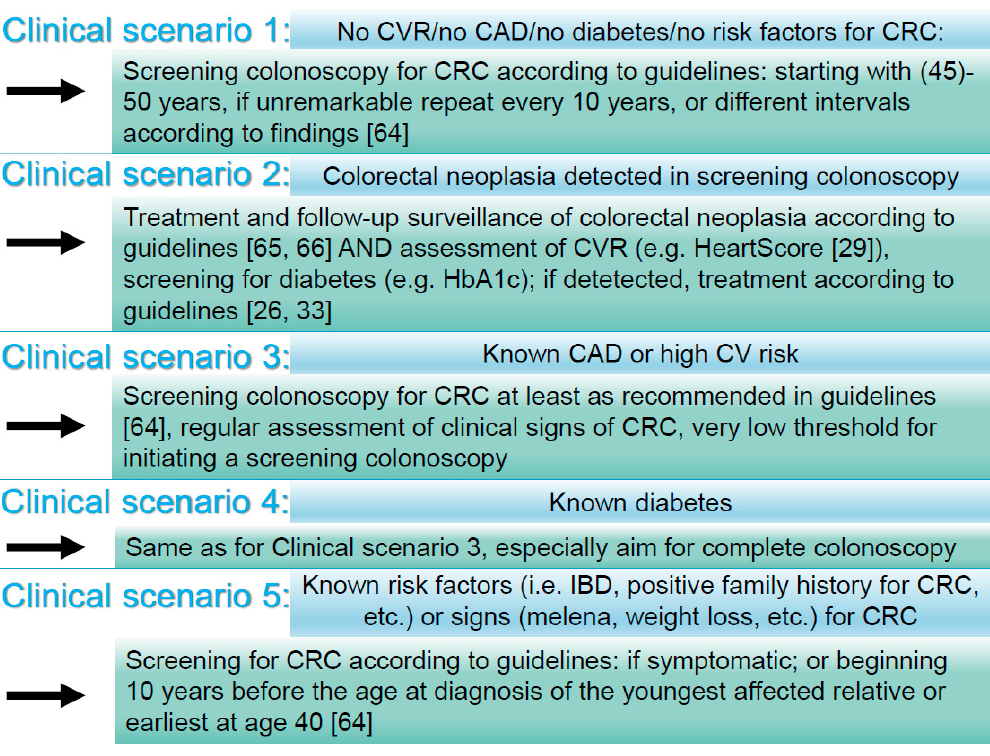
Figure 3. A proposal for an individualized screening colonoscopy approach for colorectal cancer, diabetes, cardiovascular risk, and coronary artery disease, based on our findings. Along with screening colonoscopy, other screening tests are likewise possible (fecal immunochemical test annually; high-sensitivity, annual guaiac-based fecal occult blood test; multitarget stool DNA test every three years; computed tomography colonography every five years; and flexible sigmoidoscopy every five years [26,29,33,64–66]). CVR denotes cardiovascular risk, CAD denotes coronary artery disease, CRC denotes colorectal cancer, and IBD denotes inflammatory bowel disease.